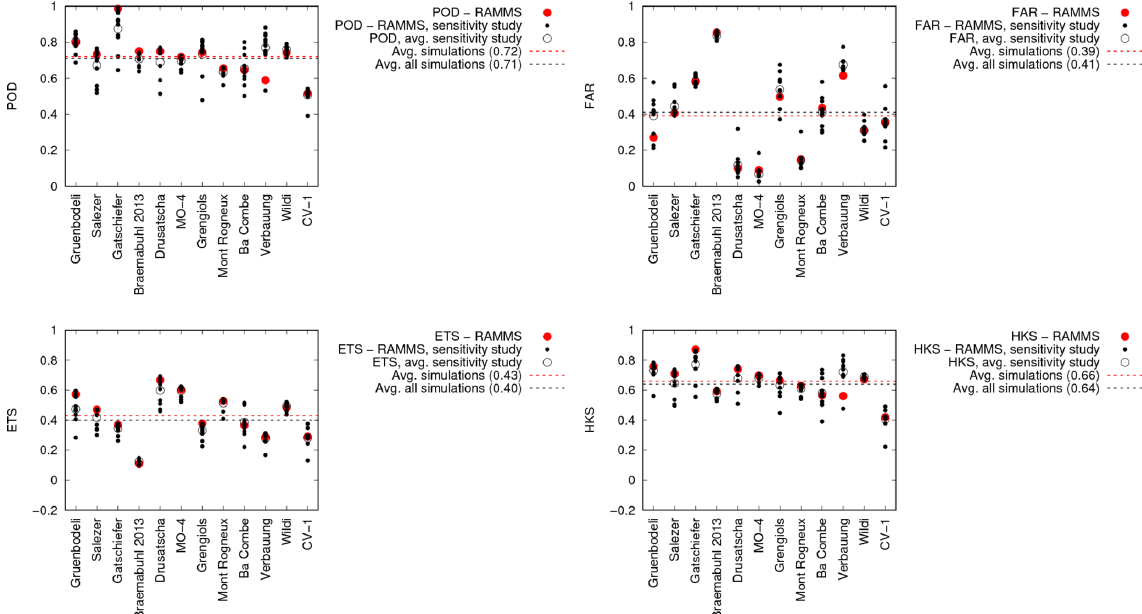
Figure 7. Sensitivity of the thermomechanical model to different snow temperature and LWC. For every avalanche path 12 different snow temperatures and LWCs in the release and erosion zones are varied, keeping the release and eroded height and density constant. Markers and colors as in Fig.